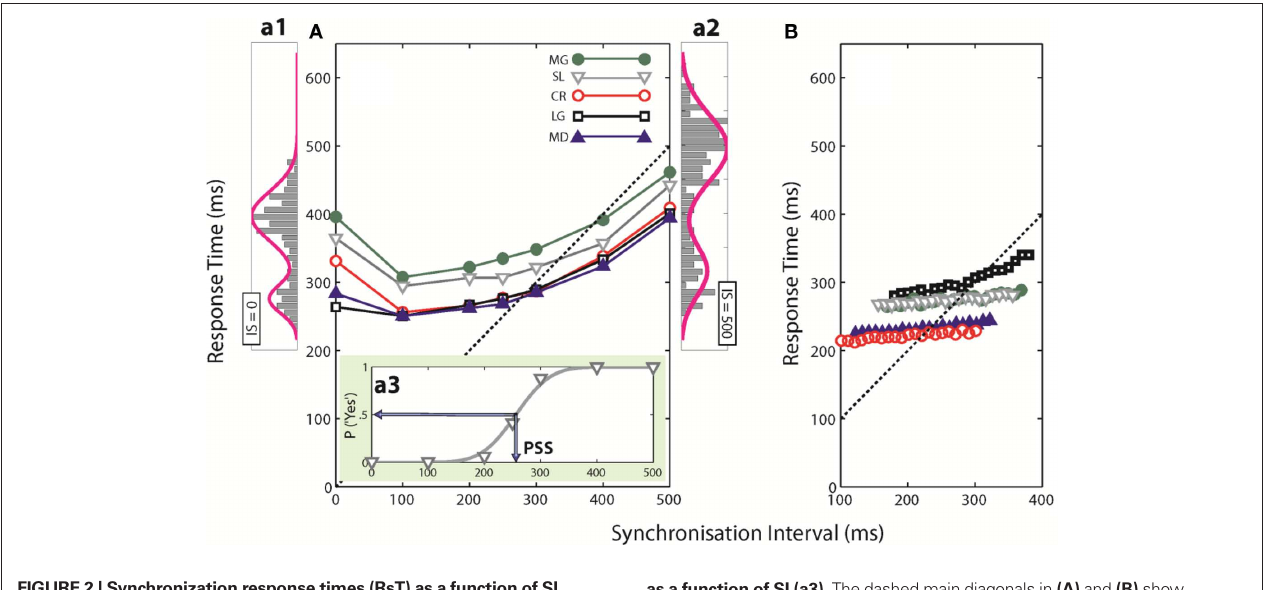
as a function of Si (a3). The dashed main diagonals in (A) and (B) show perfectly synchronized RsTs. The double arrowed right-angle lines in a3 point to this subject’s RsT at 50% “Yes” responses (i.e., the mean of the fitted Gaussian), i.e., his point of subjective synchronization referred to SI (PSS SI